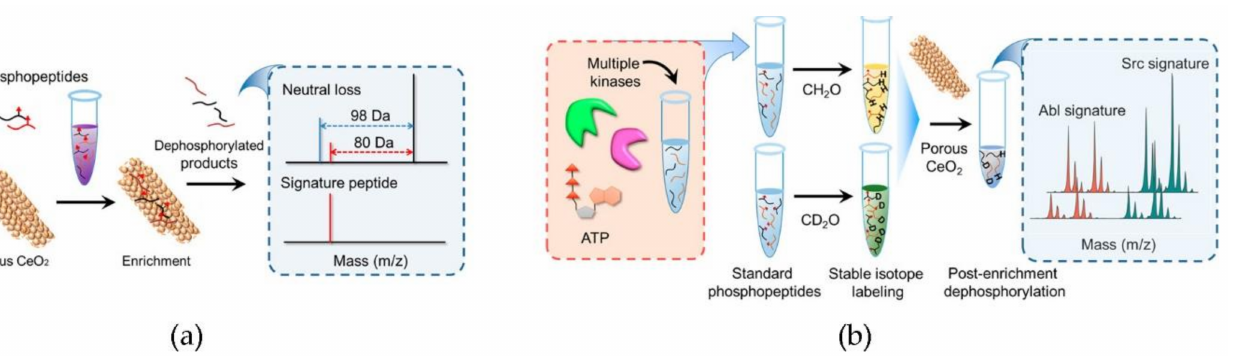
Figure 8. Multiplexed mass spectrometry approach for kinase biomarkers. ( a ) Ceria is used as MOAC sorbent and phosphorylase-mimic for phosphopeptide detection. ( b ) Ceria allows for the enhanced detection of Abl and Src kinases. Adapted with permission from [90]. Copyright © 2021, American Chemical